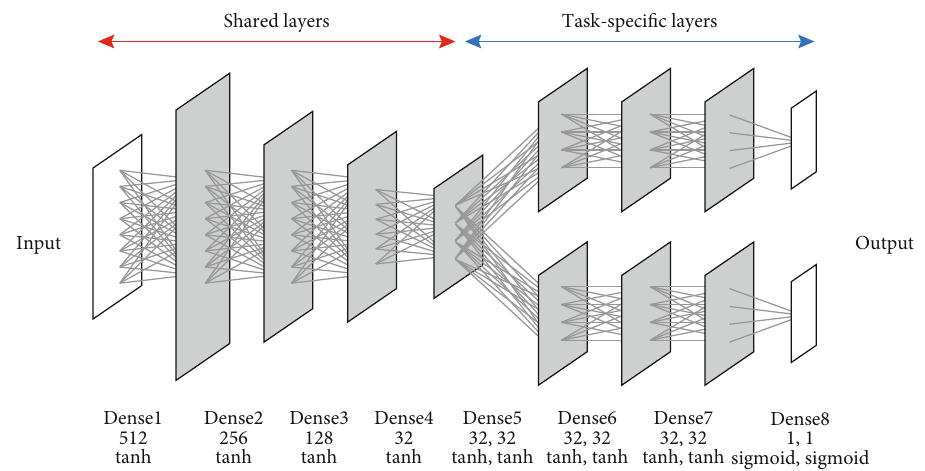
Figure 3: The neural network architecture in [9].